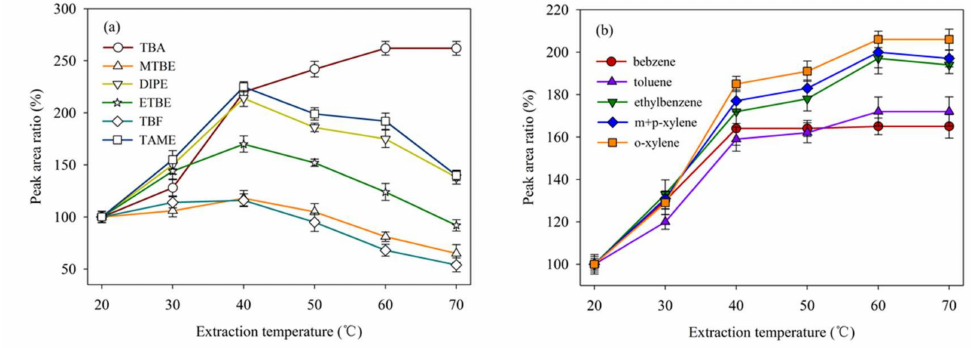
Figure 4. E ff ect of extraction temperature on signal intensities of the twelve analytes (20 µ g / L). The peak area at the extraction temperature of 20 ◦ C is used as a reference (100%). ( a ) the peak area ratio of TBA, MTBE, DIPE, ETBE, TBF, and TAME; ( b ) the peak area ratio of benzene, toluene, ethylbenze, m + p–xylene, and